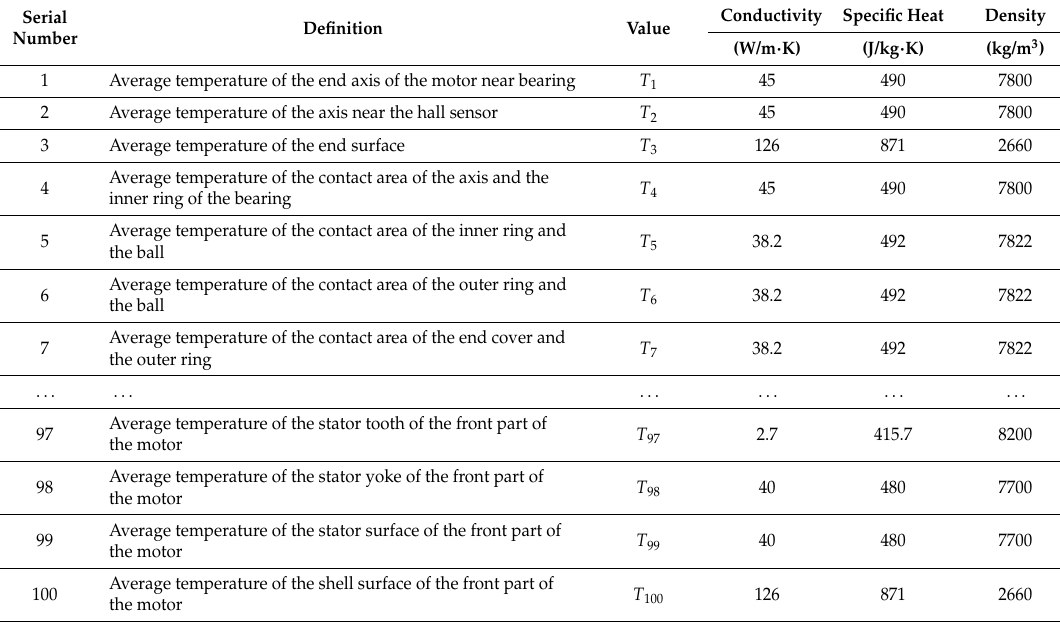
Table 2. Serial numbers and definitions of every node.